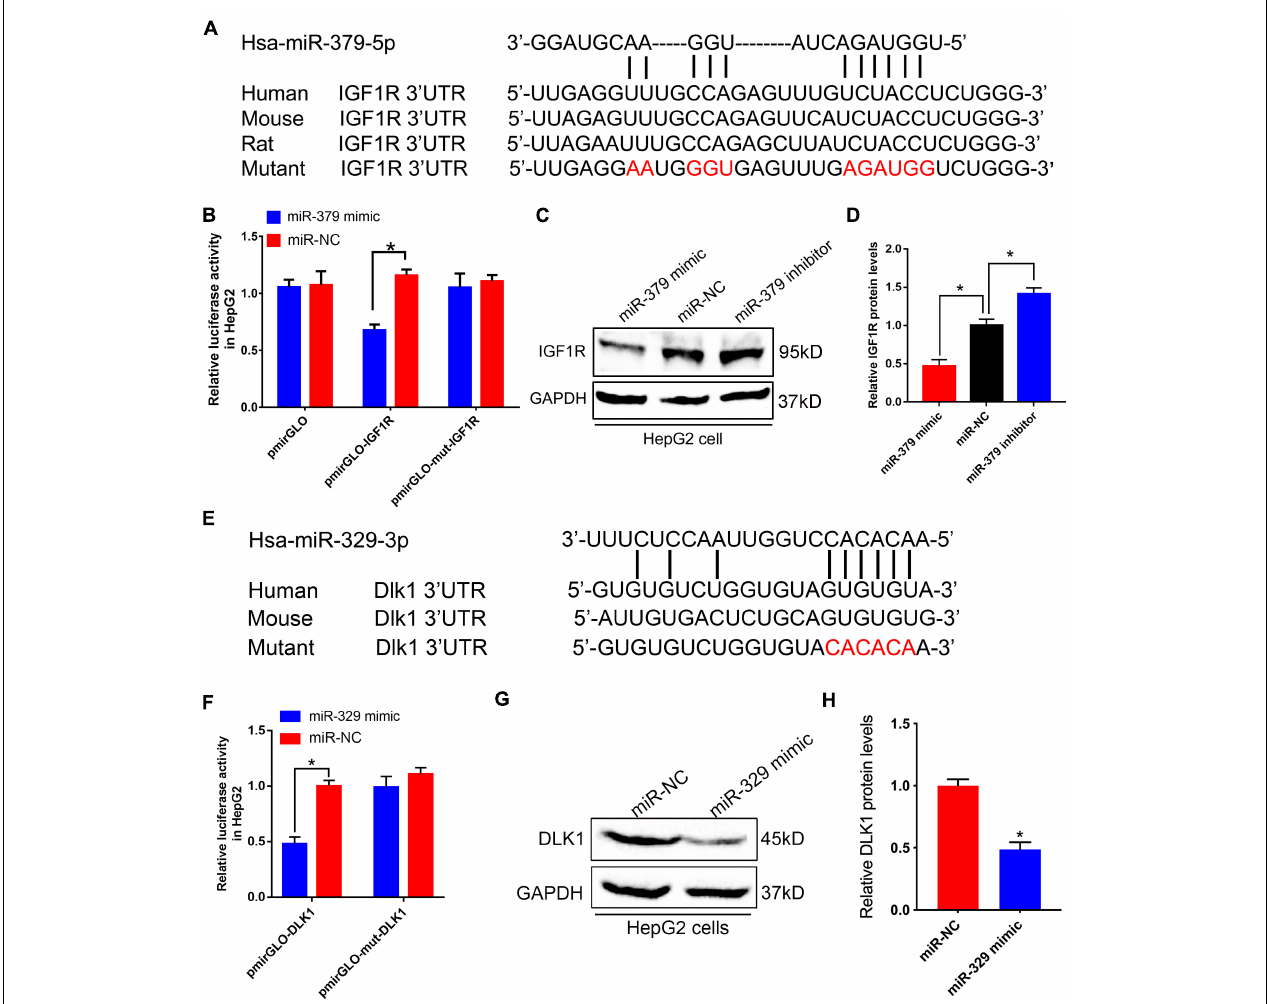
FIGURE 6 | miR-379/miR-544 cluster directly targets Igf1r and Dlk1 . (A) Sequence alignment of human miR-379-5p with 3 (cid:48) -UTRs of human, mouse, rat, and mutant Igf1r . (B) Luciferase reporter assay showing wild-type or mutant Igf1r 3 (cid:48) -UTR transfected with miR-379 mimic or negative control in HepG2 cells ( n = 3). HepG2 cells transfected with the empty luciferase reporter vector served as control. * P < 0.05. (C,D) Western blot (C) and quantitative analysis (D) of the IGF1R protein compared with GAPDH when HepG2 cells ( n = 3) were transfected with a miR-379 mimic or a miR-379 inhibitor. * P < 0.05. (E) Schematic representation of potential miR-329-3p binding sites and the designed mutant sites at Dlk1 3 (cid:48) -UTR is shown. (F) Luciferase reporter assay showing wild-type or mutant 3 (cid:48) -UTR transfected with miR-329 mimic or negative control in HepG2 cells ( n = 3). * P < 0.05. (G,H) Western blot (G) and quantitative analysis (H) of the DLK1 protein when HepG2 cells ( n = 3) were transfected with a miR-329 mimic. * P < 0.05.